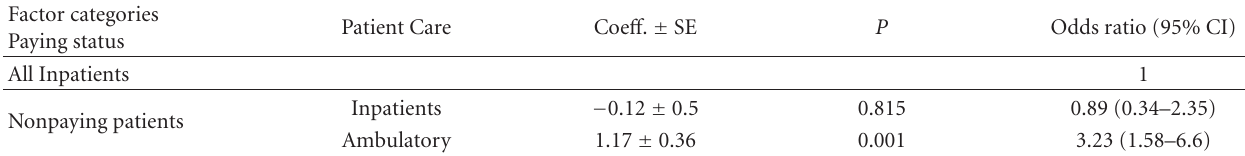
Table 6: Adjusted odds ratio of endophthalmitis in nonpaying patients with Inpatient and ambulatory patient